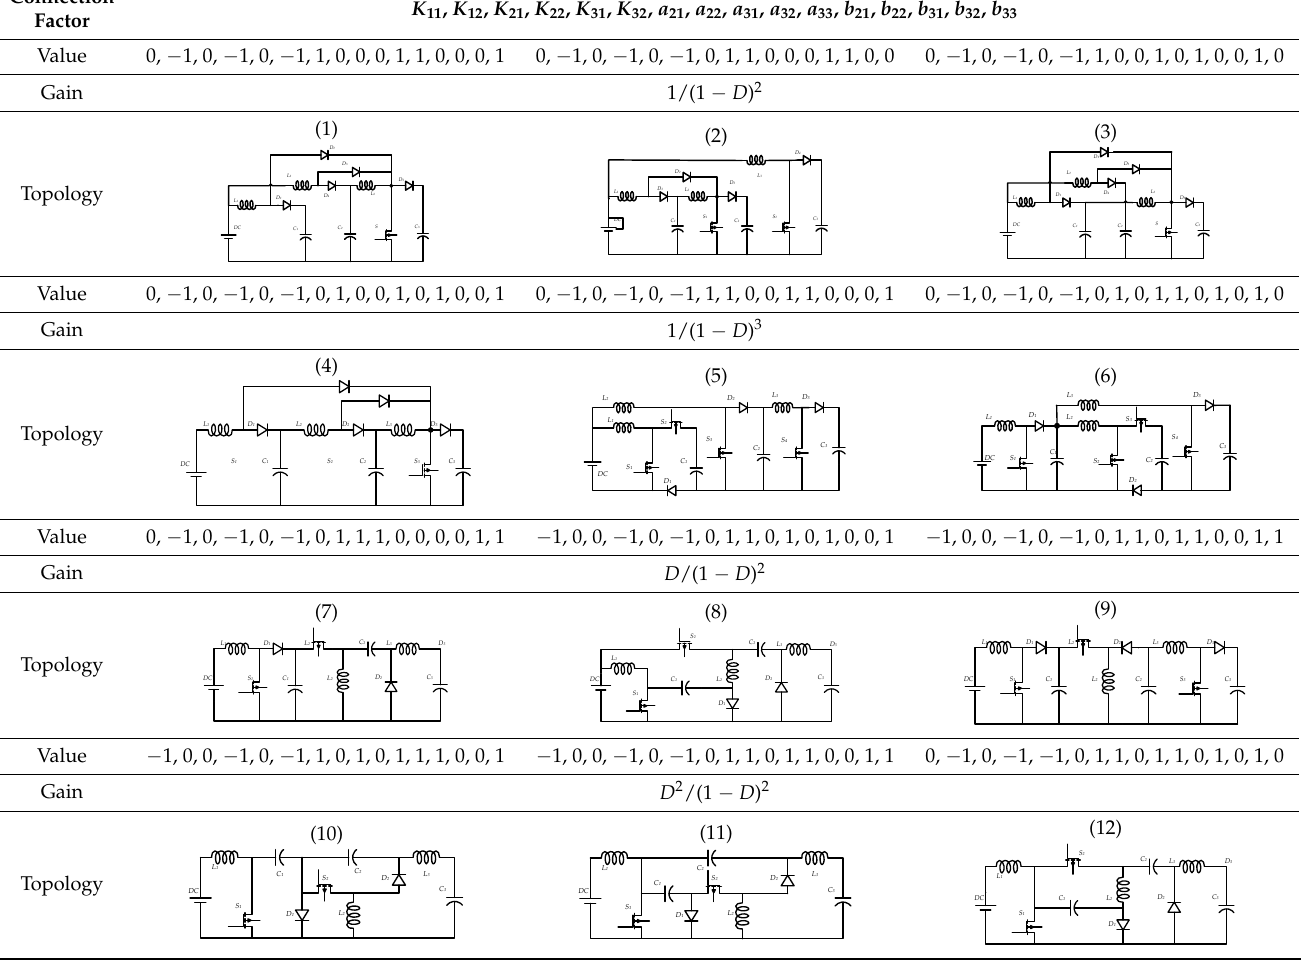
Table 3. Obtained topologies for four different voltage gains.